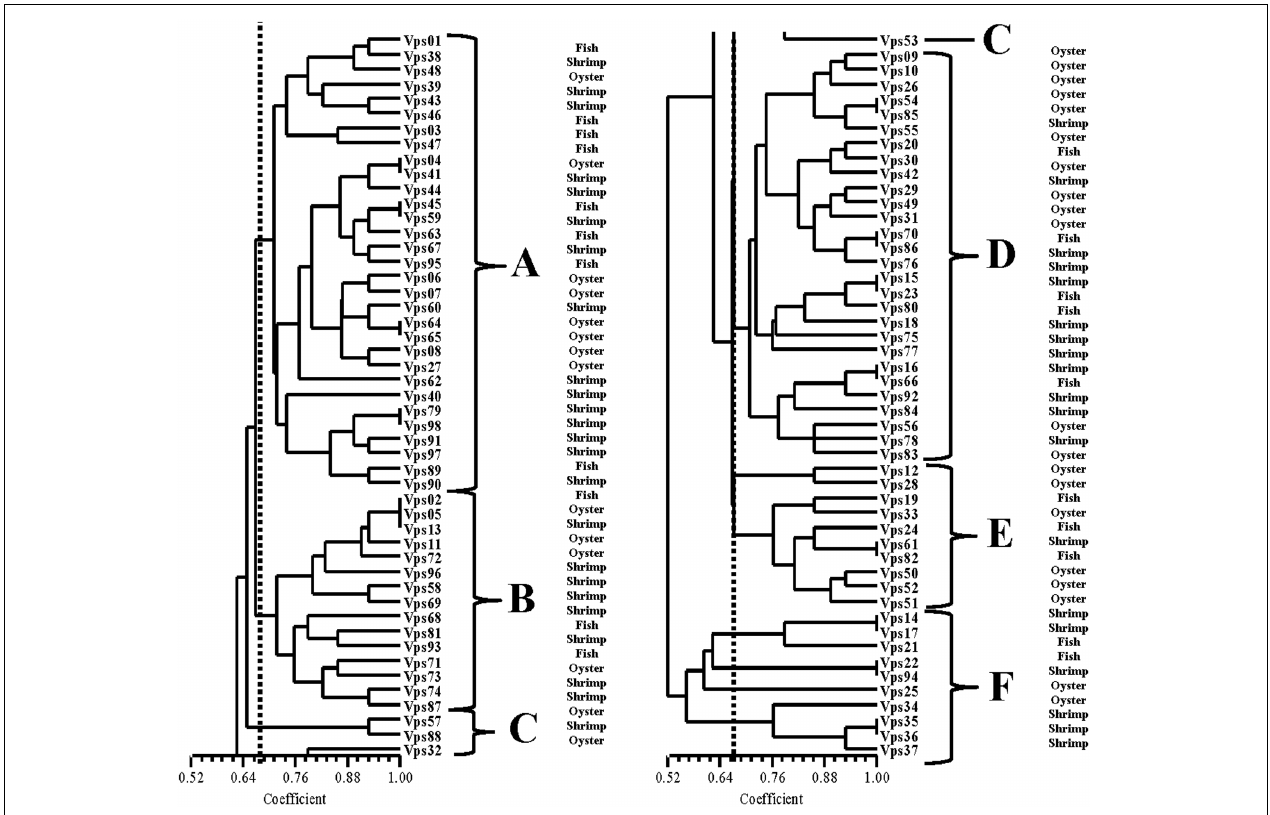
FIGURE 2 | ERIC-PCR DNA fingerprint analysis of V. parahaemolyticus